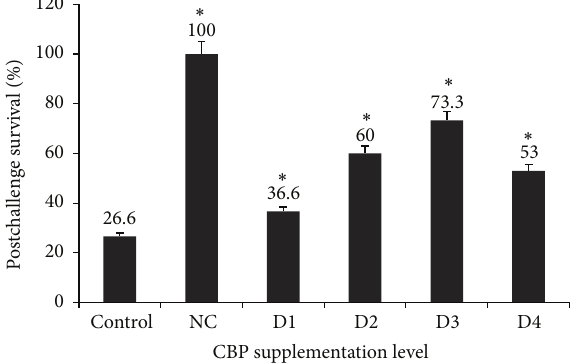
Figure 4: Effect of dietary CBP administration on the survival of Labeo rohita ( 𝑛 = 30 ) after challenge with A. hydrophila . Postchallenge survival (percent) in each dietary group is indicated at the top of each column. Bars represent the mean ± SEM and asterisks represent levels of significant differences compared to the control ( 𝑃 < 0.05 ). Note: NC (negative control); C (basal diet); D1 (basal diet + 0.1% CBP); D2 (basal diet + 0.2% CBP); D3 (basal diet + 0.3% CBP); D4 (basal diet + 0.4%